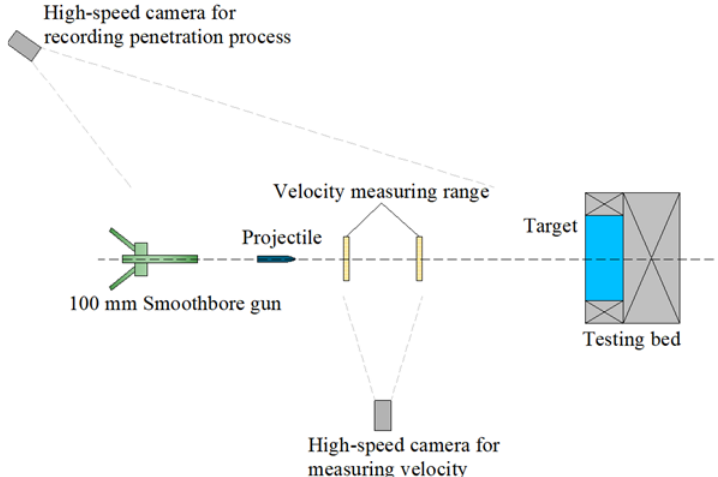
Figure 5. Experimental setup for penetration tests.